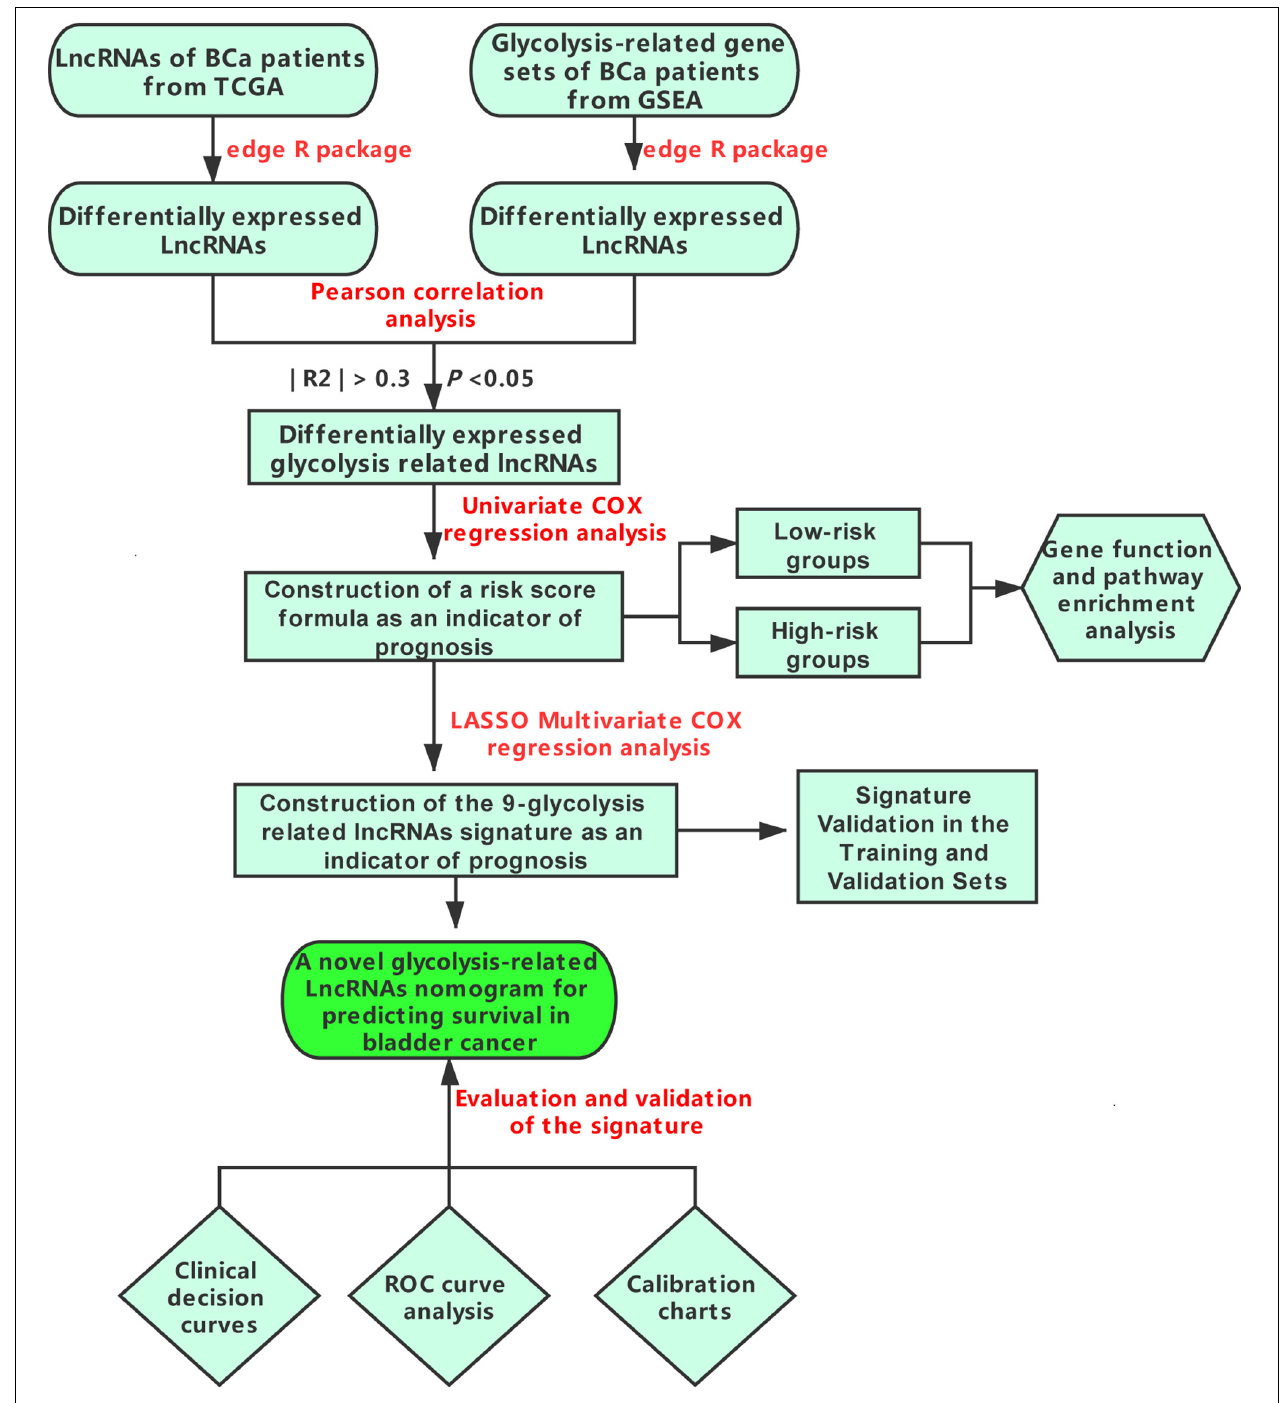
FIGURE 1 | Flow chart of key steps during the process.